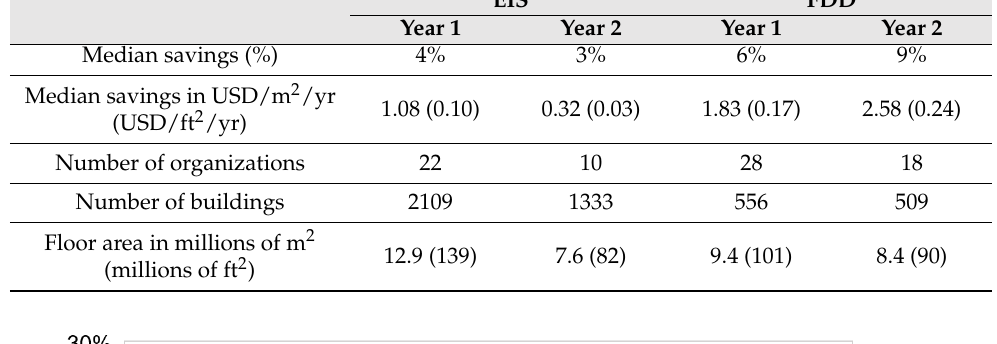
Table 2. Energy savings for organizations with EIS and organizations with FDD.